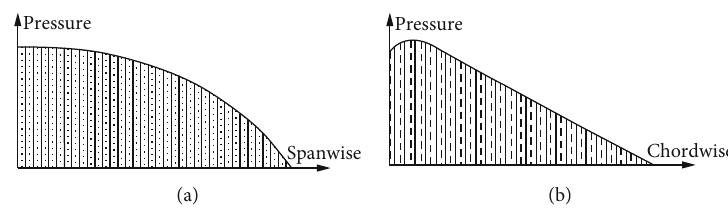
Figure 1: Spanwise load distribution (a) and chordwise load distribution (b). Unit: